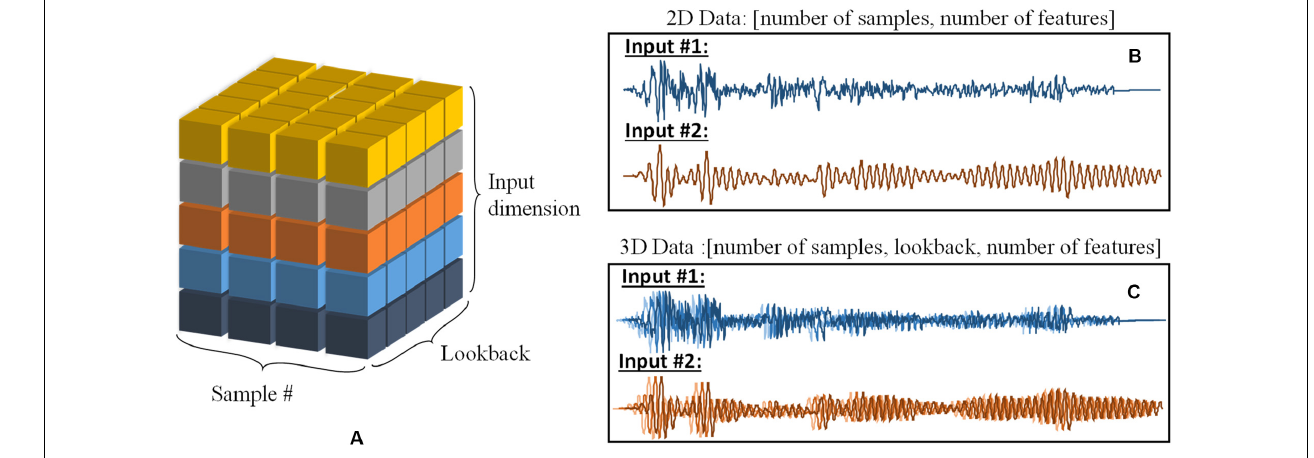
FIGURE 11 | (A) Schematic representation of 3D data format, (B) input dataset in 2D format, and (C) input dataset when reshaped into 3D format.